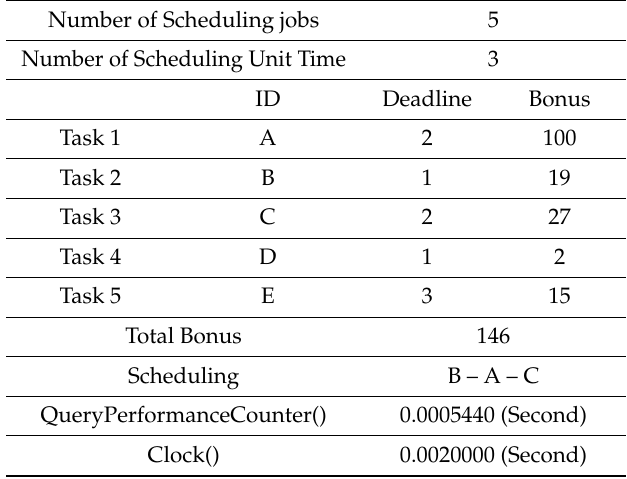
Table 3. The Result of Scheduling and Runtime Obtained by Executing the Source Implemented based on the Floy-Warshall algorithm (a Dynamic Programming).